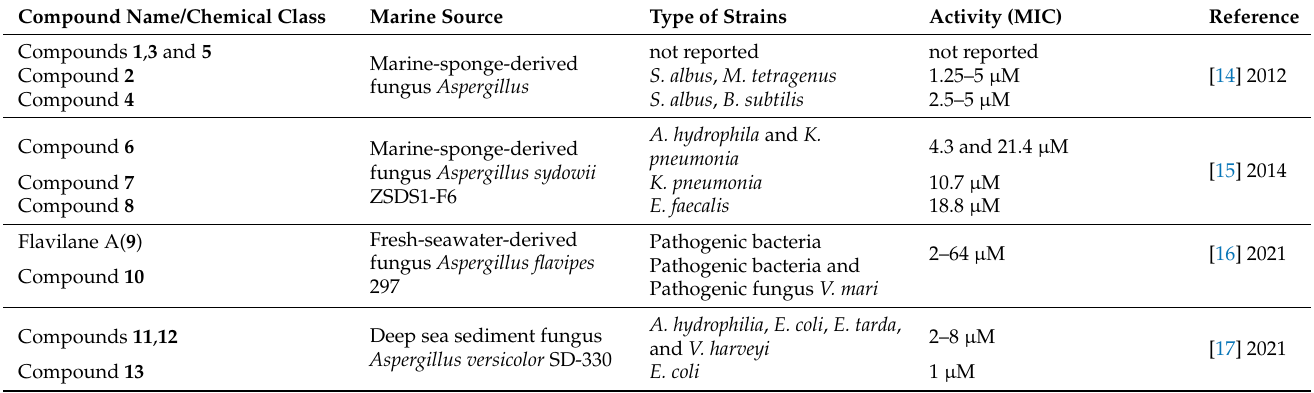
Table 1. List of sesquiterpenoids isolated from marine fungi Aspergillus sp. with potential biological